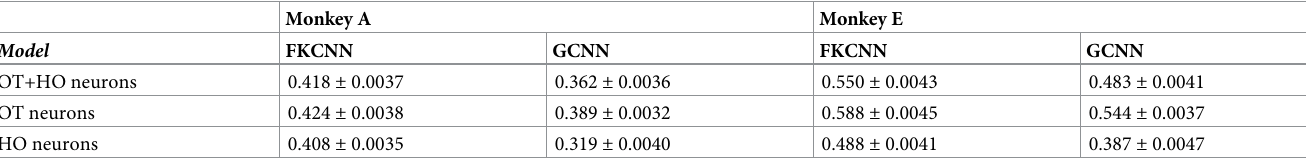
Table 3. Average and standard error model performance on neurons with different types.